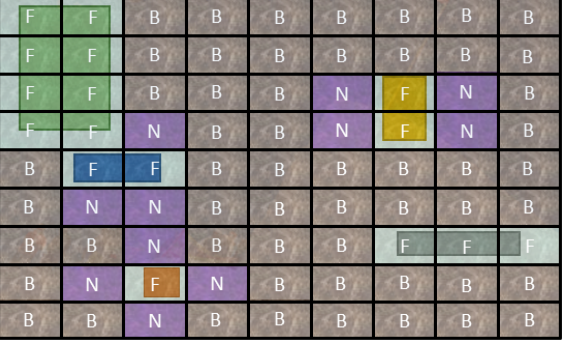
Figure 6. The illustration of the class label assignment for different object sizes. The Foreground cells are marked by “F”. The Background cells are marked by “B”. The Neutral cells are marked by